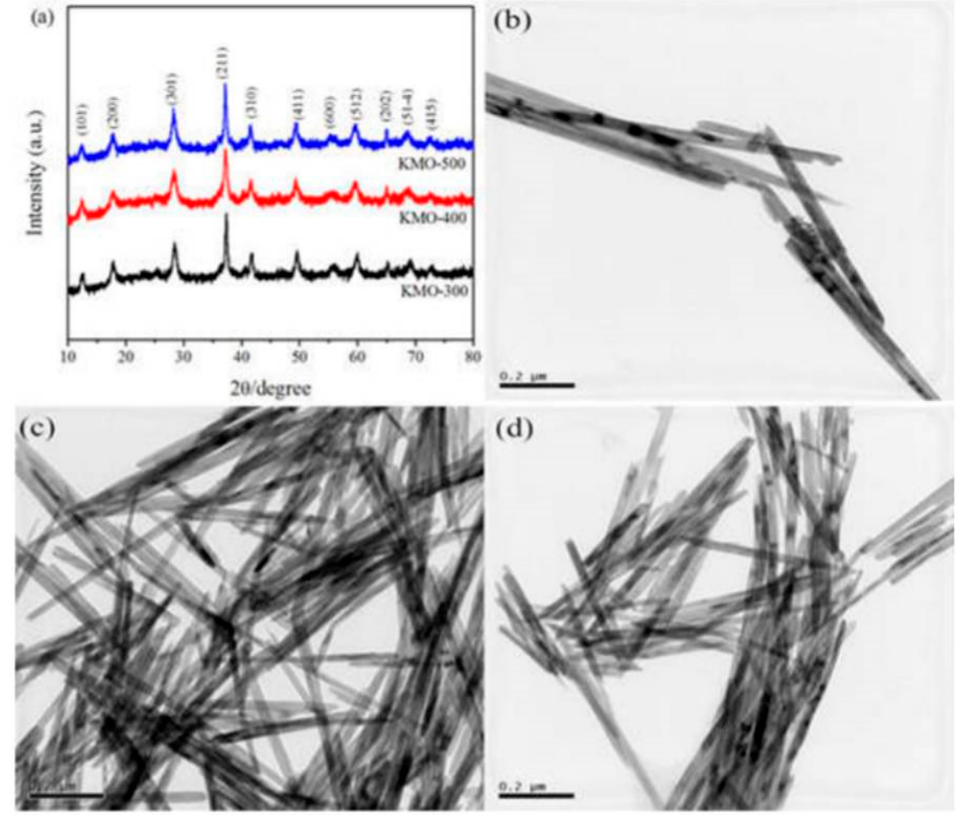
Figure 6. ( a ) XRD patterns of KMn 8 O 16 and SEM images of KMn 8 O 16 prepared at ( b ) 300 °C, ( c ) 400 °C and ( d ) 500 °C Reprint with permission [61] © IOP Publishing Ltd.